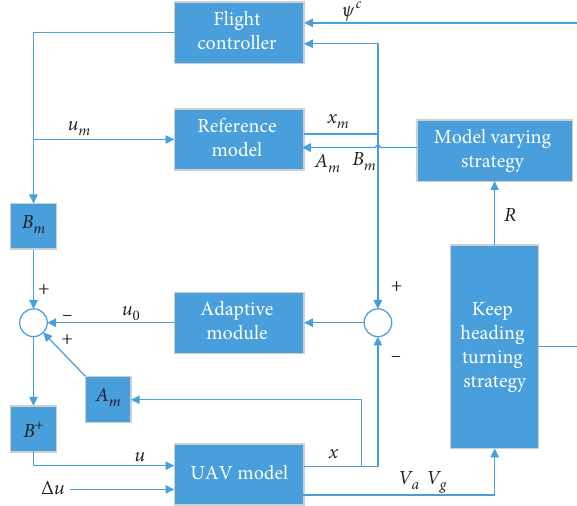
Figure 7: “Reject external disturbance” flight mode control system. Table 1: UAV physical parameters.